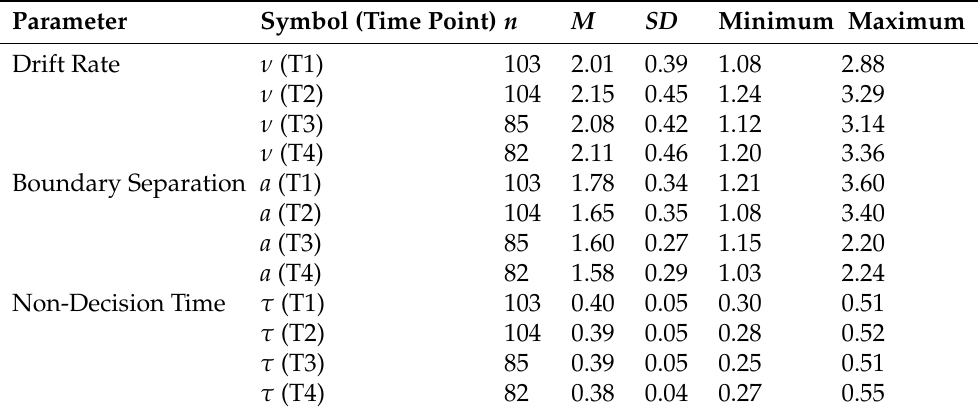
Table A3. Summary statistics of the individual diffusion model parameter estimates for each time point for Group 2.